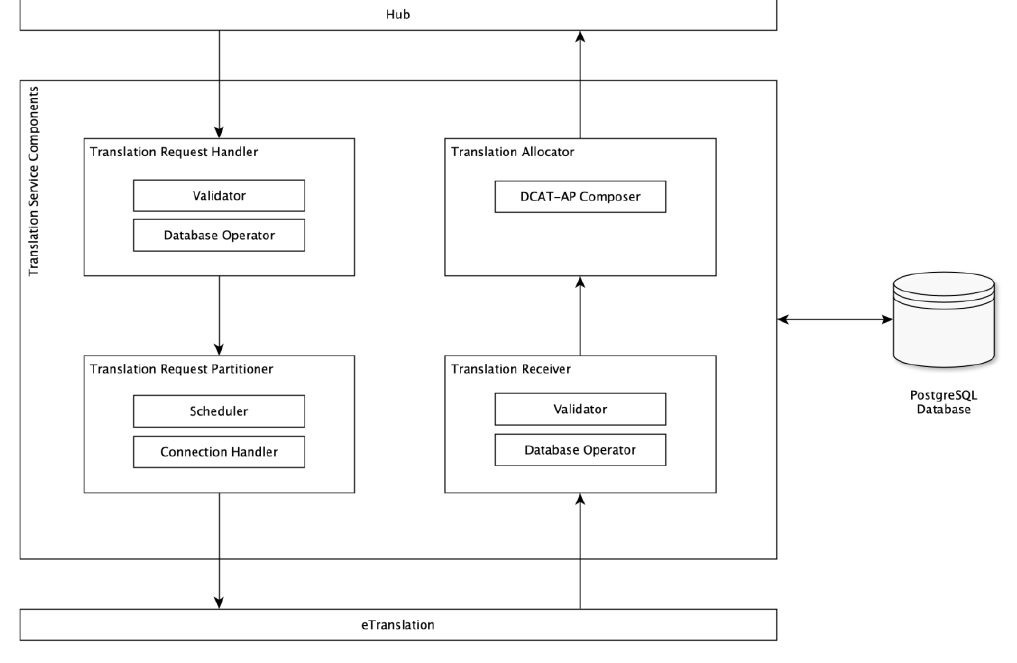
Figure 5: Internal structure of the Translation